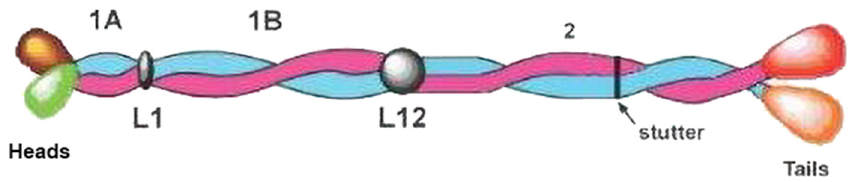
Figure 10. Schematic structure of the KIF molecule with a Type I and a Type II chain in axial register and parallel to one another. The 1A, 1B, and 2 segments have a heptad substructure and form a left-handed two-stranded coiled-coil with connecting linkers L1 and L12. At the N-terminal end of segment 2 the constituent chains have a hendecad repeat which causes the chains to lie approximately parallel to the axis rather than being coiled about it. The N-terminal (head) and C-terminal (tail) domains enclose the central rod domain. Figure reproduced from [71] with permission of Springer.